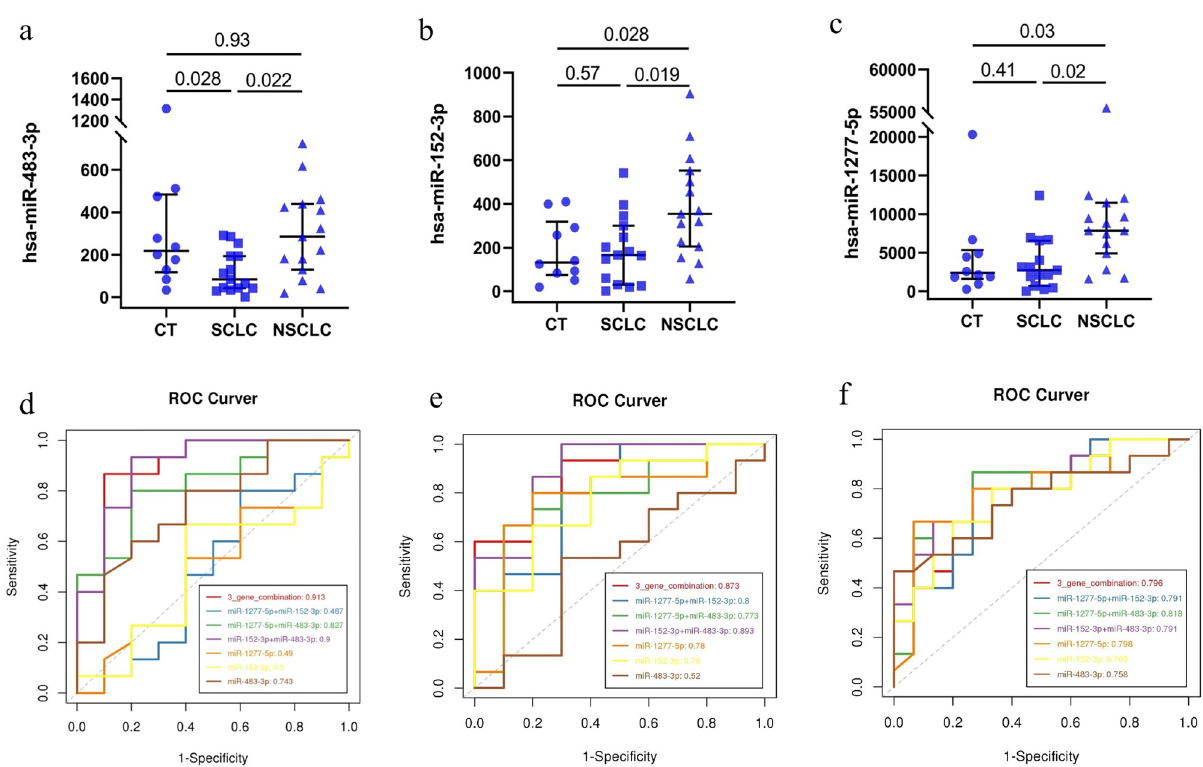
Figure 7. The expression levels and AUC of miR-483-3p, miR-152-3p, and miR-1277-5p of plasma-derived sEVs for validation. ( a – c ). The expression levels of miR-483-3p, miR-152-3p, and miR-1277-5p, respectively. The ordinate (y axis) is relative expression of miRNA. The abscissa of the upper edge is P -values, estimated by Mann–Whitney independent t-testing. ( d – f ) The AUC result of miR-483-3p, miR-152-3p, and miR-1277-5p from CT versus SCLC ( d ), CT versus NSCLC( e ) , and SCLS versus NSCLC ( f ) , and combinations of two or three of these